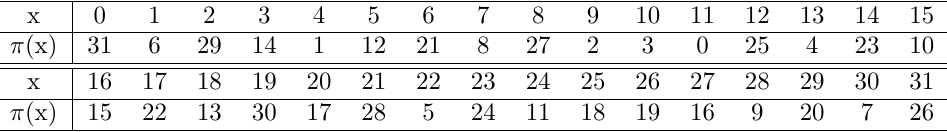
Table 3: Shuffle π mixing the 32